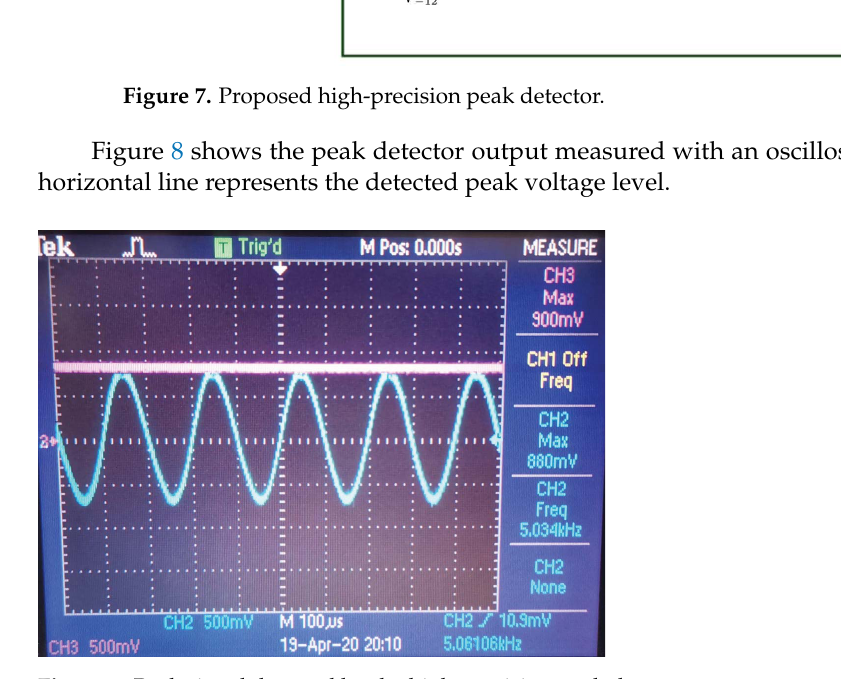
Figure 8. Peak signal detected by the high-precision peak